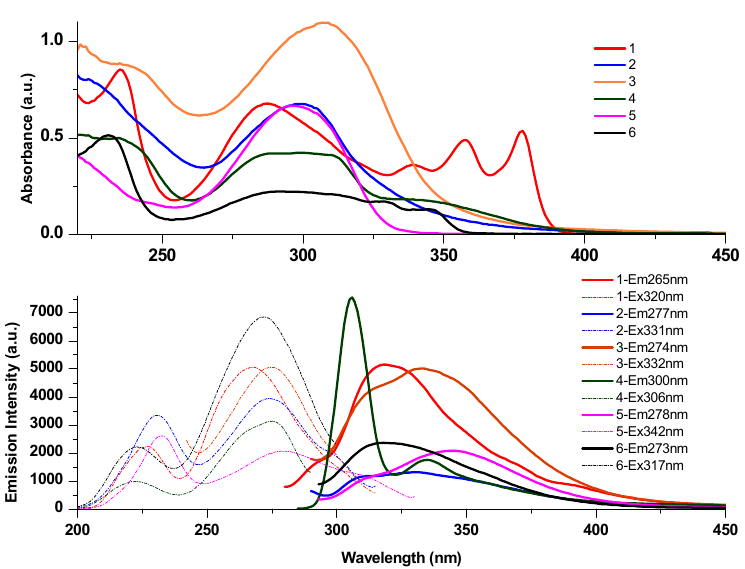
Figure 5. UV-vis absorption spectra (top), excitation spectra (bottom left, dashed line) and emission spectra of 1 – 6 (bottom right, solid line) in THF (2 × 10 − 5 M) were recorded at room temperature in air. Excitation wavelengths of 265 nm for 1 , 277 nm for 2 , 274 nm for 3 , 300 nm for 4 , 278 nm for 5 , and 273 nm for 6 were applied to obtain emission spectra.